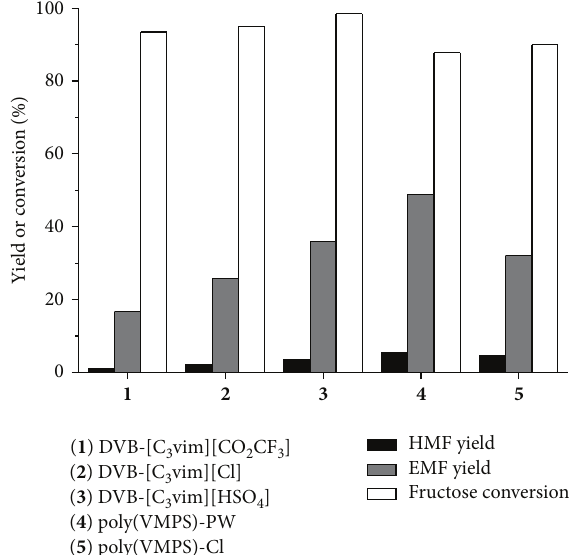
Figure 4: Catalytic dehydrative etherification of fructose in ethanol to EMF with various catalysts at 110 ∘ C for 7h.